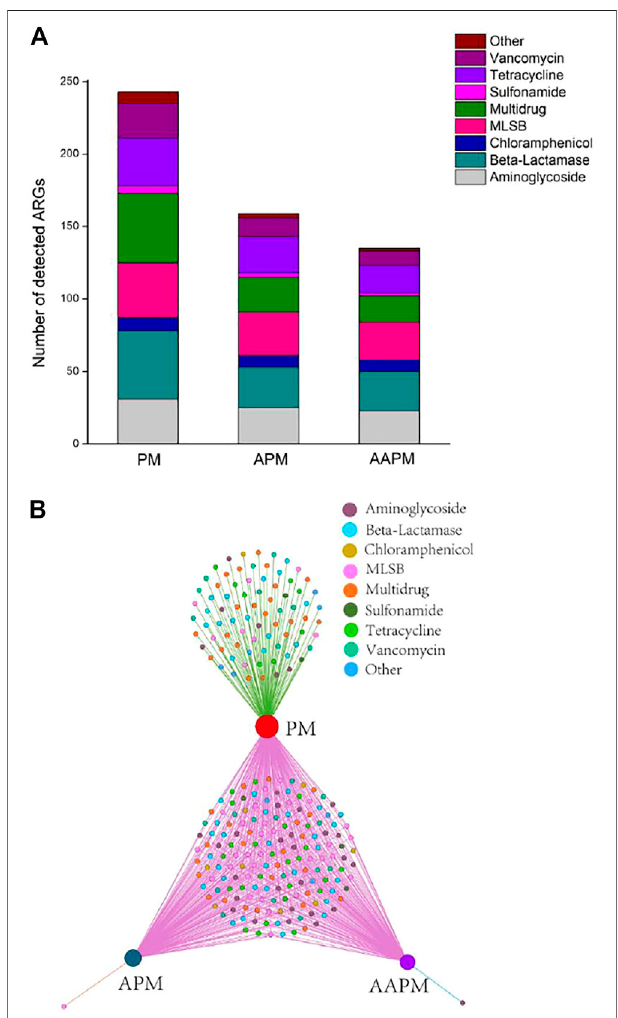
FIGURE 2 | Number of detected ARGs attached to strawberries collected from fi elds with long-term use of raw poultry manure (PM), aerobic composting poultry manure (APM), and anaerobic composting poultry manure (AAPM) (A) ; Bipartite network analysis showing unique ARGs (B)